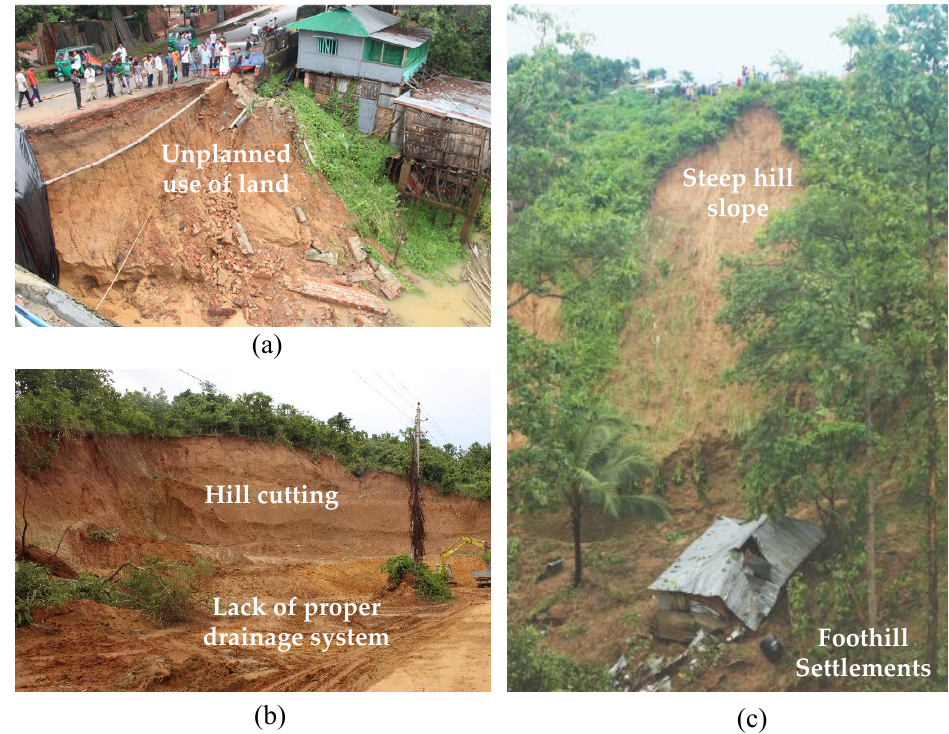
Figure 7. ( a ) Partially damaged road in Bilaichari, Rangamati; ( b ) unplanned road construction without proper drainage system; ( c ) slope failure due to a steep slope and unauthorized foothill settlement at south Manikchari. Unplanned foothill settlements are one of the major reasons for the toe slope failure.